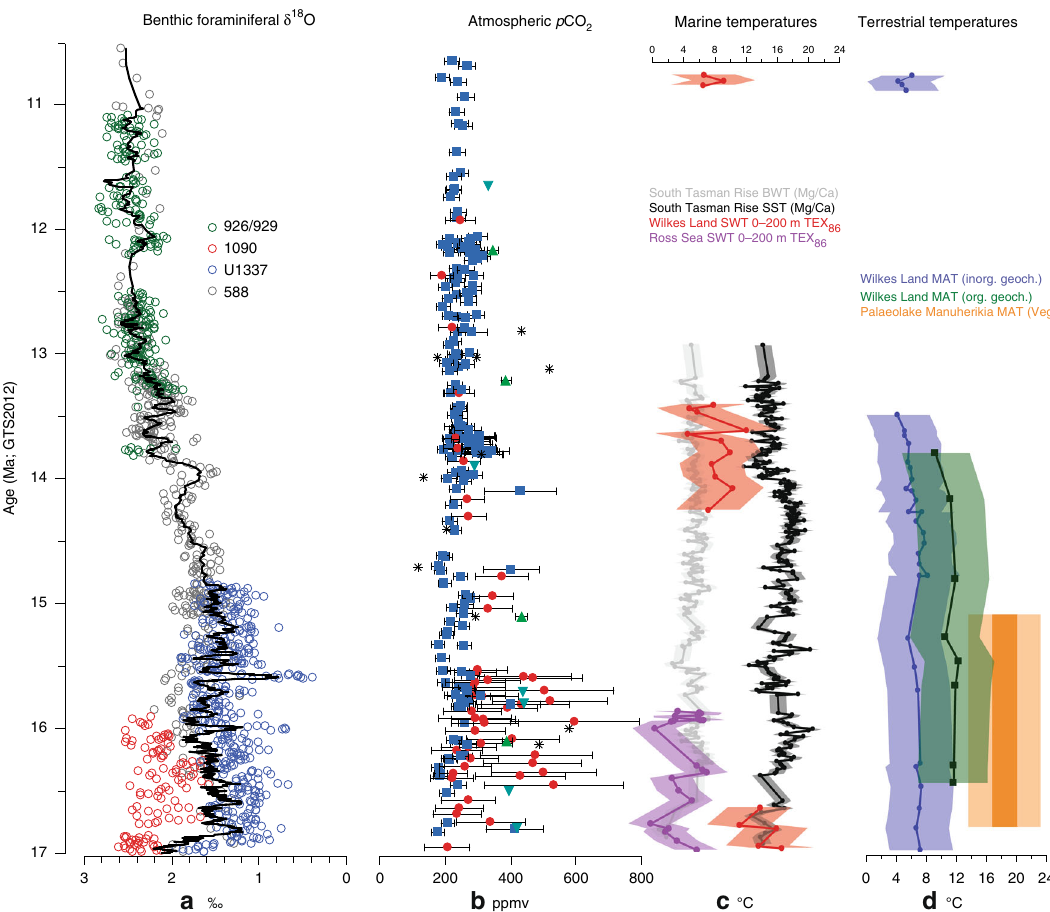
Fig. 3 Southern high-latitude Miocene temperature and p CO 2 change. a Deep-sea benthic foraminifer oxygen isotope record from ODP Sites 588, 926, 929, 1090 (see ref. 12 ), and IODP Site U1337 11 ; b atmospheric p CO 2 reconstructions 11 – 17 . Error bars represent uncertainties in underlying assumptions of each proxy; c bottom-water (BWT) and surface-water temperature (SST) reconstructions from Site 1171 South Tasman Rise 9 (Mg/Ca, calibration error ± 3 °C), seawater temperature (SWT) for Ross Sea AND-2A 21 and Wilkes Land Site U1356 ( TEX L , calibration error ± 4 °C); d mean annual continental 86 temperature (MAT) reconstructions for the Paci fi c sector of the Southern Ocean based on inorganic 53 and organic geochemistry from Wilkes Land (calibration errors ± 4 °C and ± 5 °C, respectively) and macro fl ora remains (Veg.) from Palaeolake Manuherikia 28 in New Zealand (calibration error ± 5